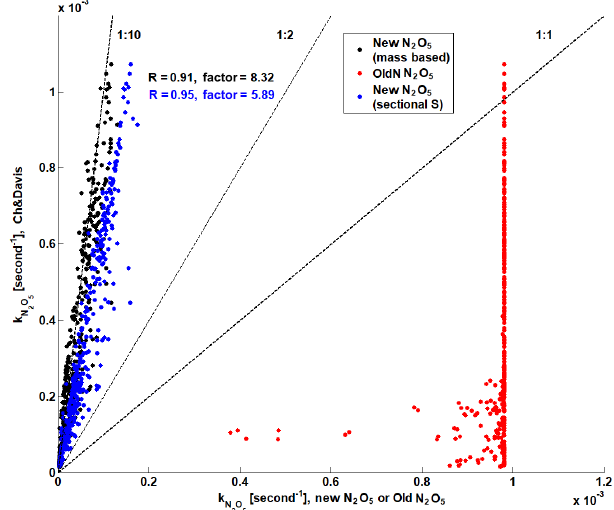
Figure 4. Comparison between the sectional-based Ch&Davis (“Davis” of Chang et al., 2016) and mass-based NewN2O5 (mass based, black), NewN2O5 (with a sectional-based particle surface area, blue), and OldN2O5 (red). The results are offline calculated on the basis of the WRF-Chem simulation with a sectional aerosol treatment